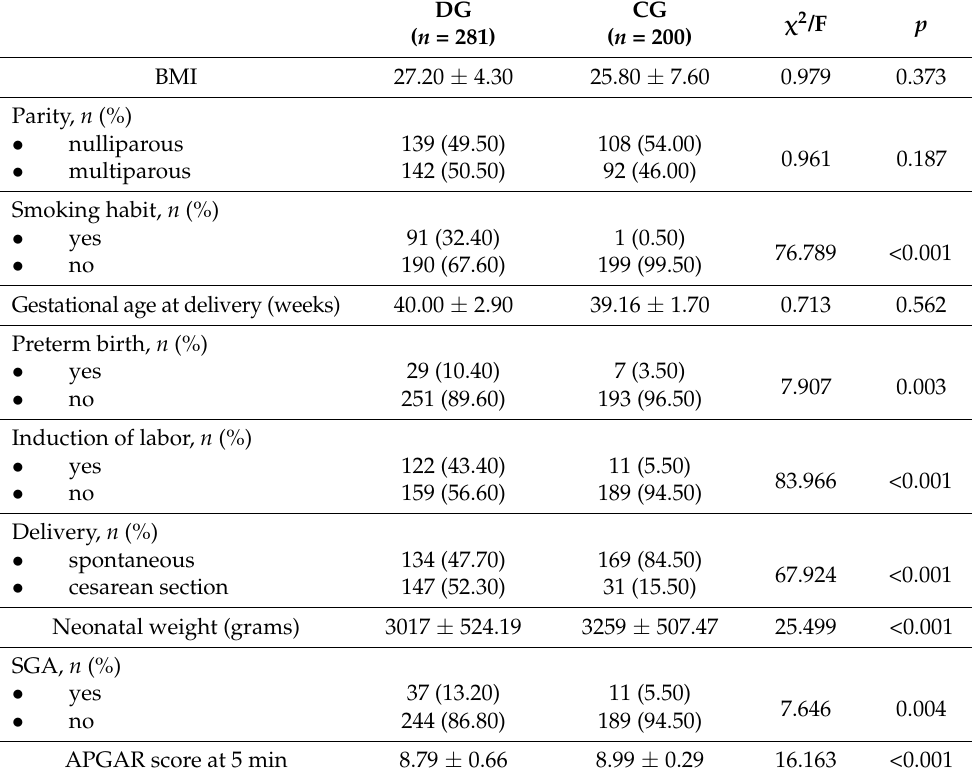
Table 1. Comparison of demographic and clinical variables of the group of pregnant women with depressive disorders (DG, n = 281) vs. the group of matched controls with physiological pregnancy (CG, n = 200).